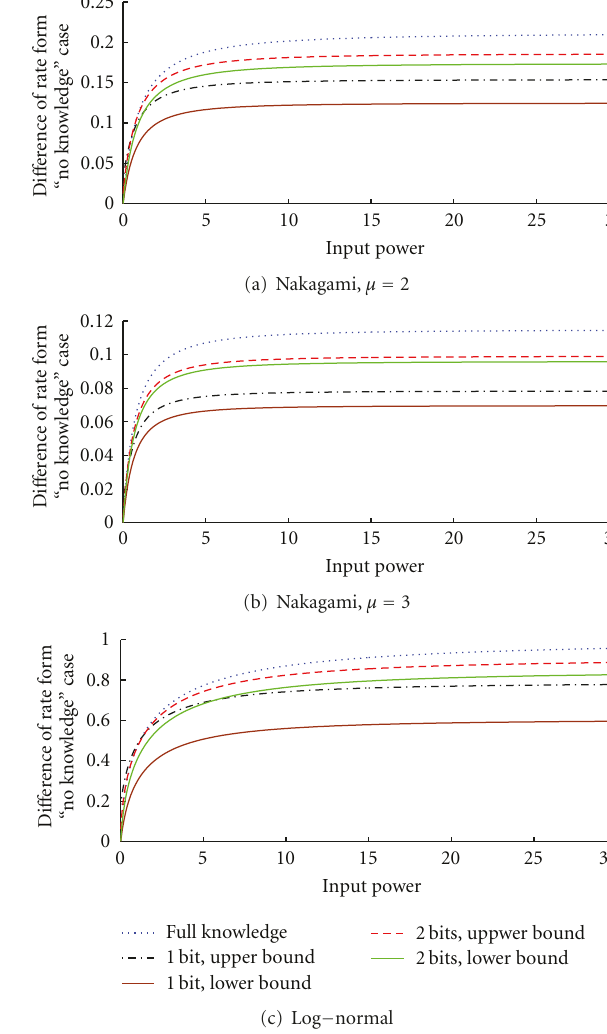
Figure 4: Increase in achievable rate bounds relative the “no knowledge” lower bound using 1 and 2bits equal probability quantization, short-term power